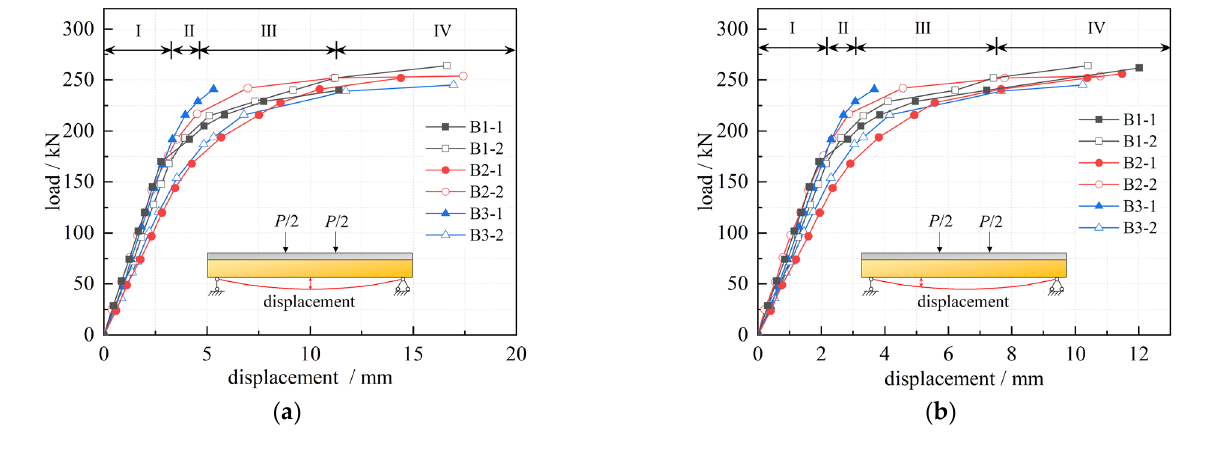
Figure 8. Load-deflection curves; ( a ) mid-span; ( b ) 1/4 span.